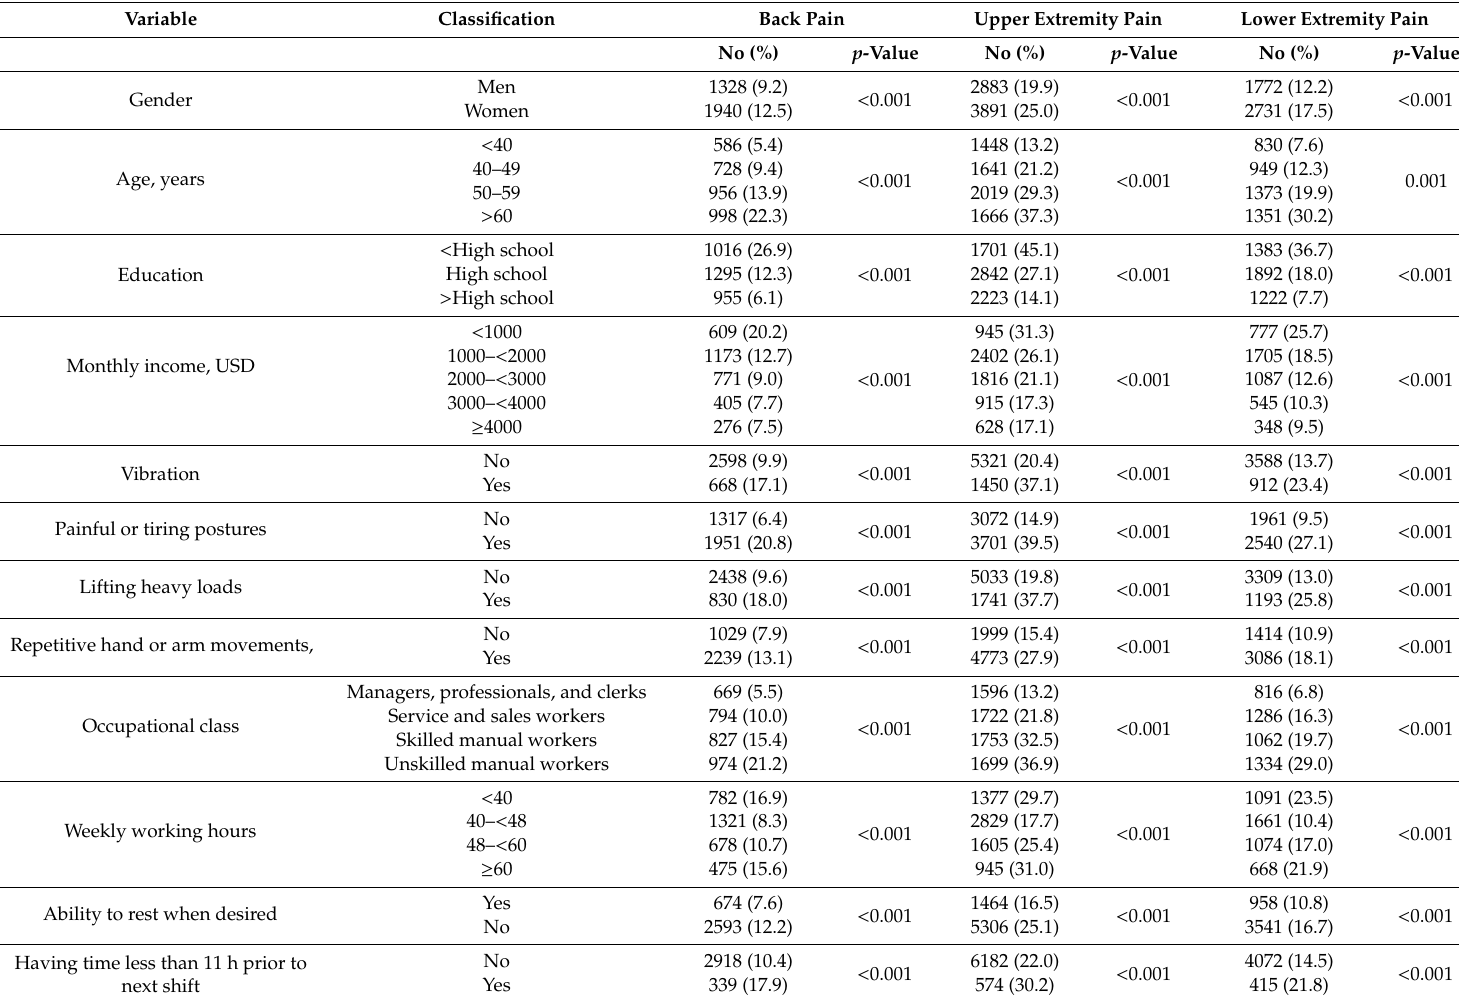
Table 2. The proportion of musculoskeletal pain by demographic, socioeconomic, and work factors (N = 30,065).